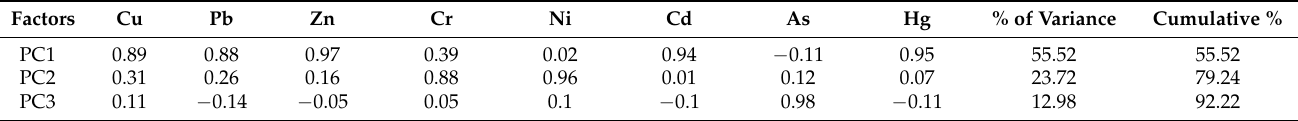
Table 5. Rotated component matrix of heavy metals in